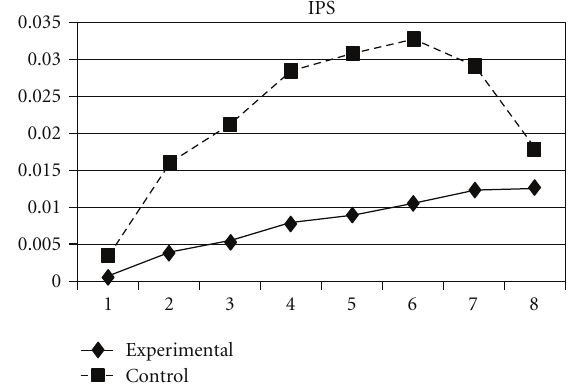
Figure 7: Growth trajectories of the experimental group (all participants) and control group using the composite score of illegal drug use as the outcome